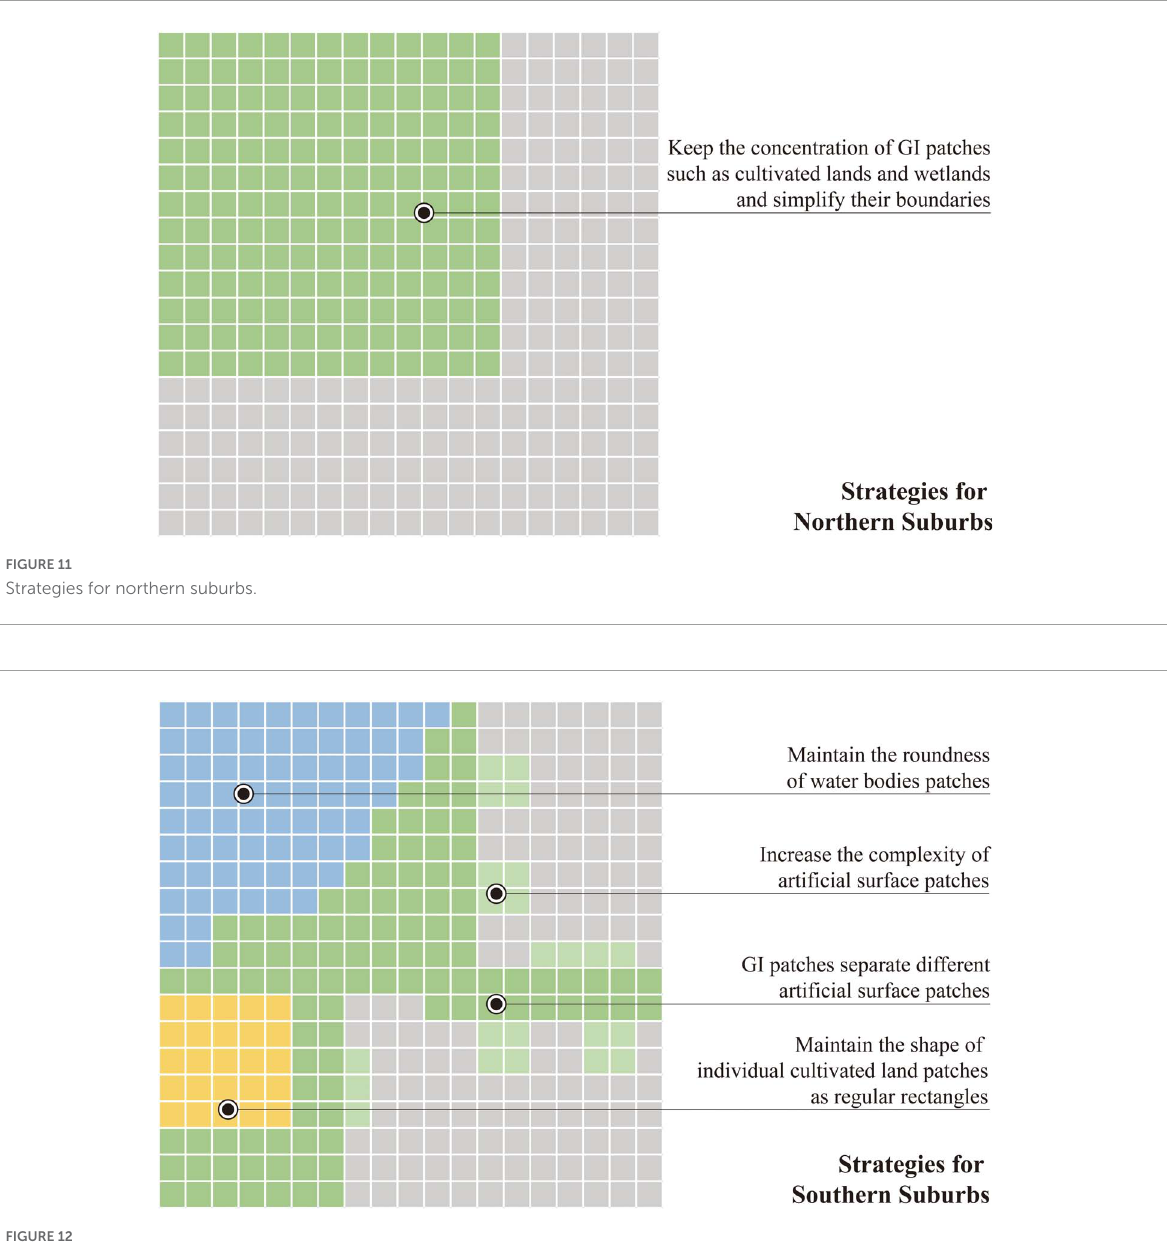
FIGURE12 Strategies for southern